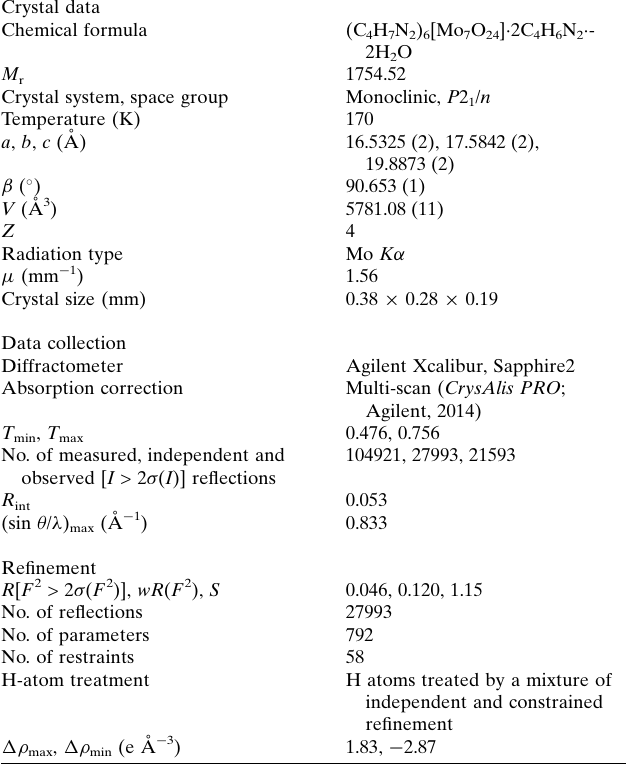
Computer programs: CrysAlis PRO (Agilent, 2014), SIR92 (Altomare et al. , 1992), SHELXL97 (Sheldrick, 2008), ORTEP-3 for Windows and WinGX (Farrugia, 2012), Mercury (Macrae et al. , 2008) and PLATON (Spek, 2009).